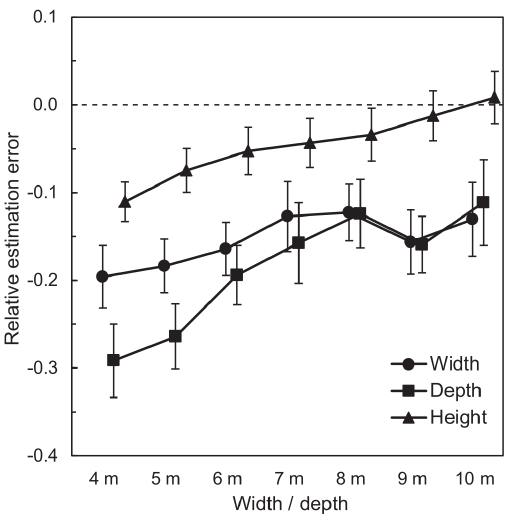
Figure 9. Experiment 2: Mean relative estimation errors of the three room dimensions as a function of width/depth. Error bars show 6 1 SEM of the 39 subjects in each condition.